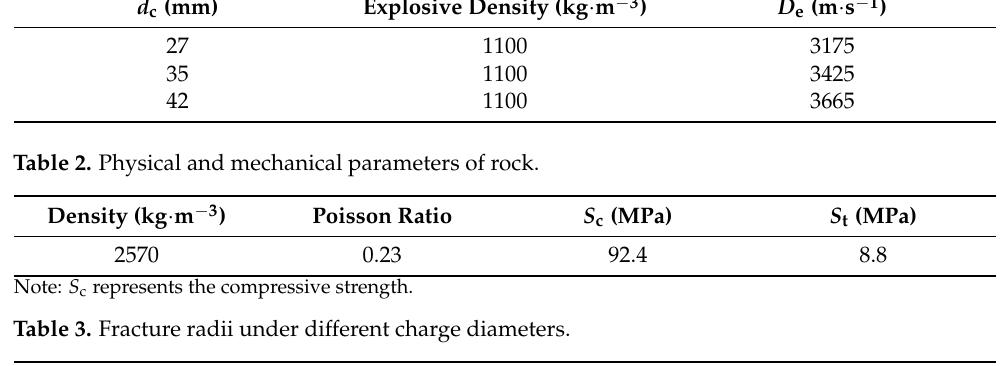
Figure 3. Relationship between detonation velocity and cartridge diameter. Table 1. Detonation velocities under different cartridge diameters.